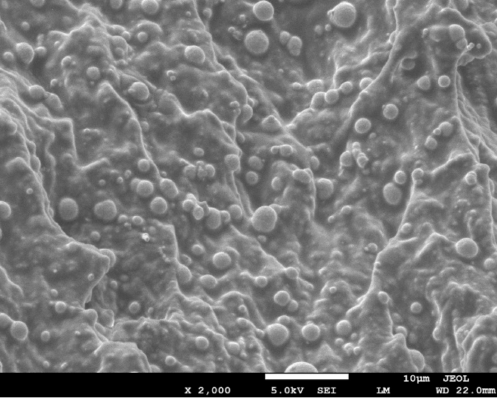
Figure 2. SEM image of the prepared isotropic magnetorheological elastomer (MRE) material.